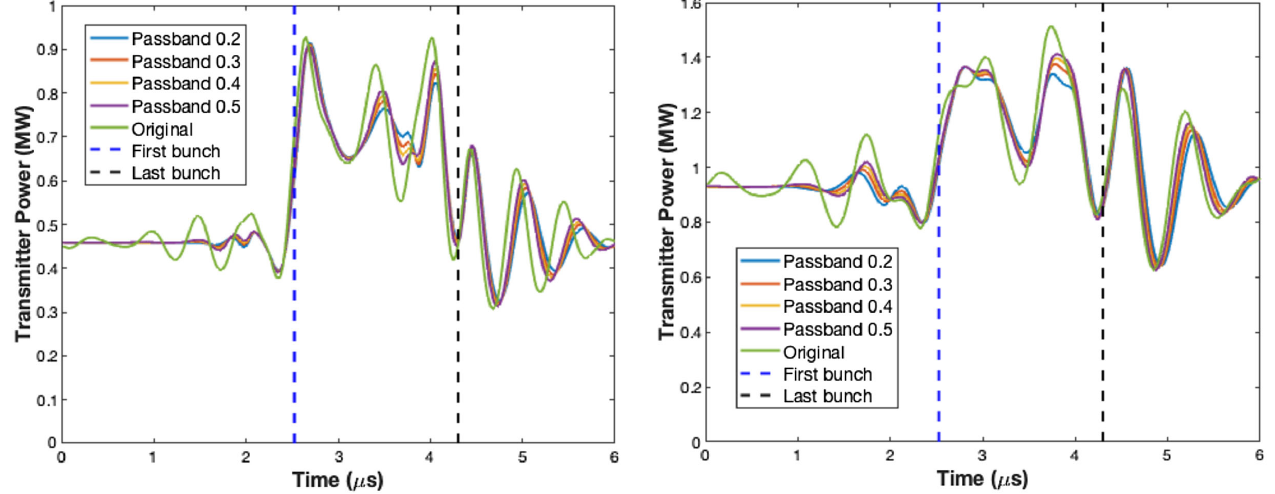
FIG. 21. Transmitter power comparison Left: three-section cavity. Right: four-section cavity.